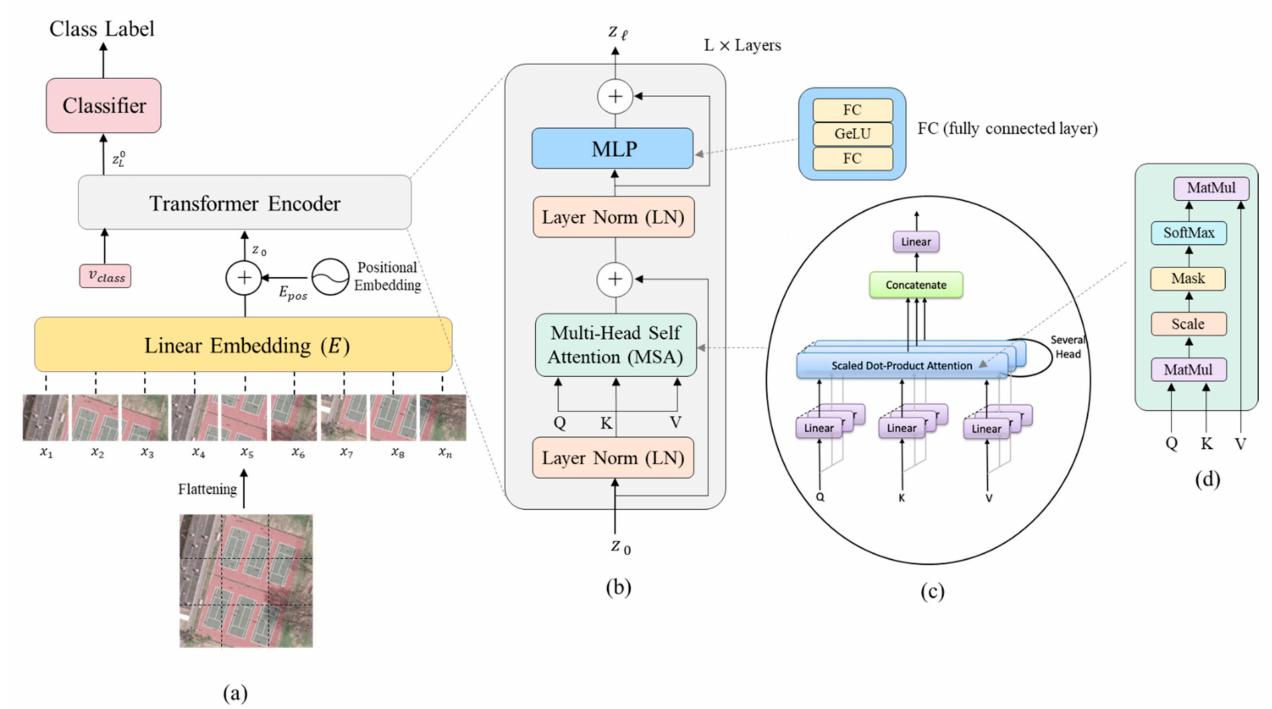
Figure 2. The Vision Transformer architecture: ( a ) the main architecture of the model; ( b ) the Transformer encoder module; ( c ) the Multiscale-self attention (MSA) head, and ( d ) the self-attention (SA)